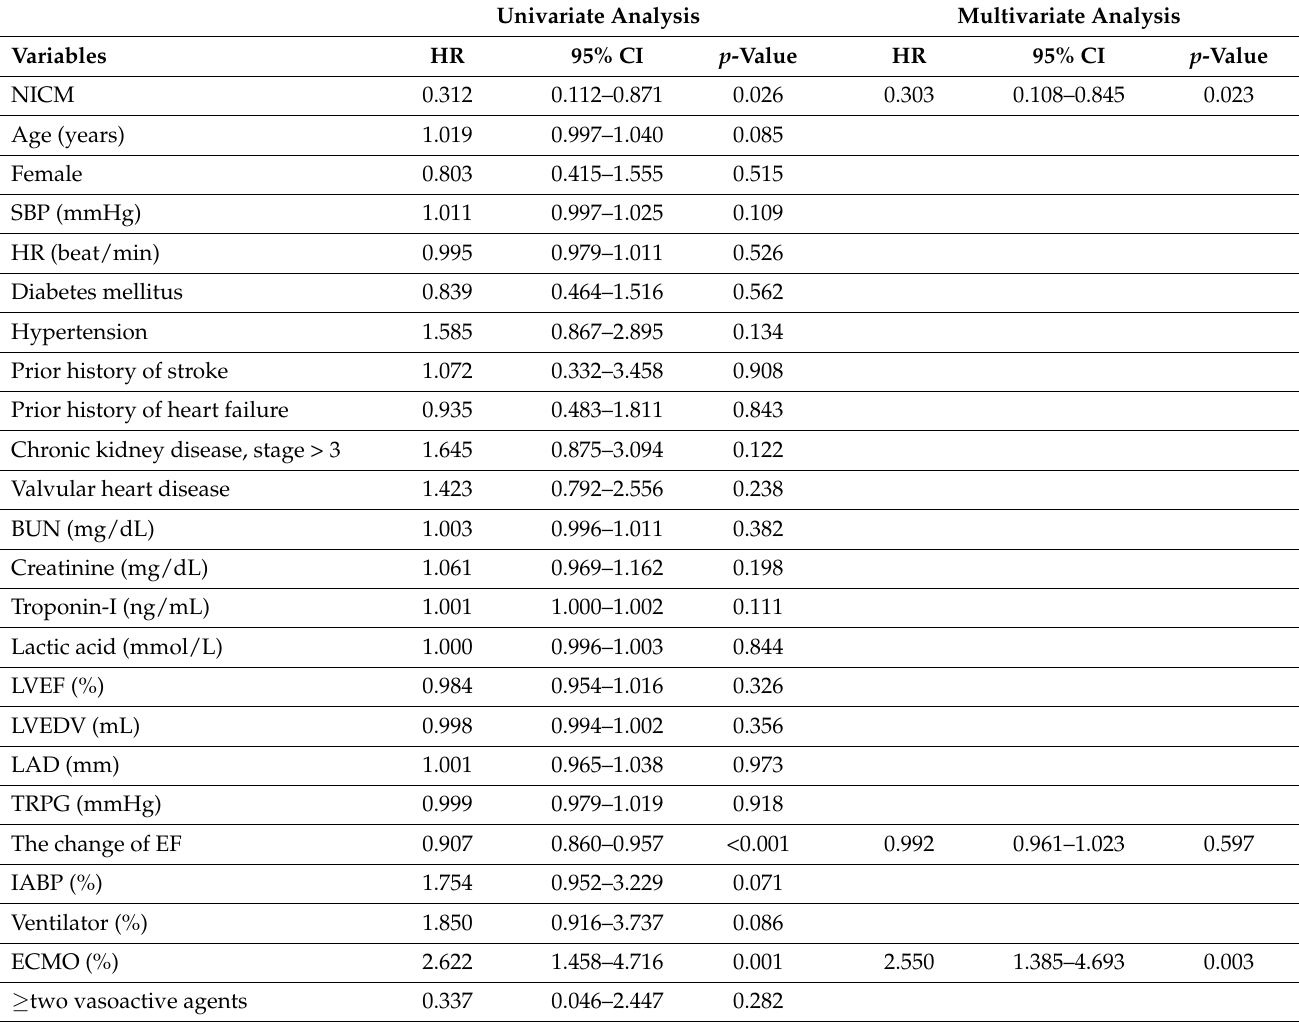
Table 4. Univariate and multivariate Cox regression analyses of predictors of 30 day all-cause mortality. Univariate Analysis Multivariate